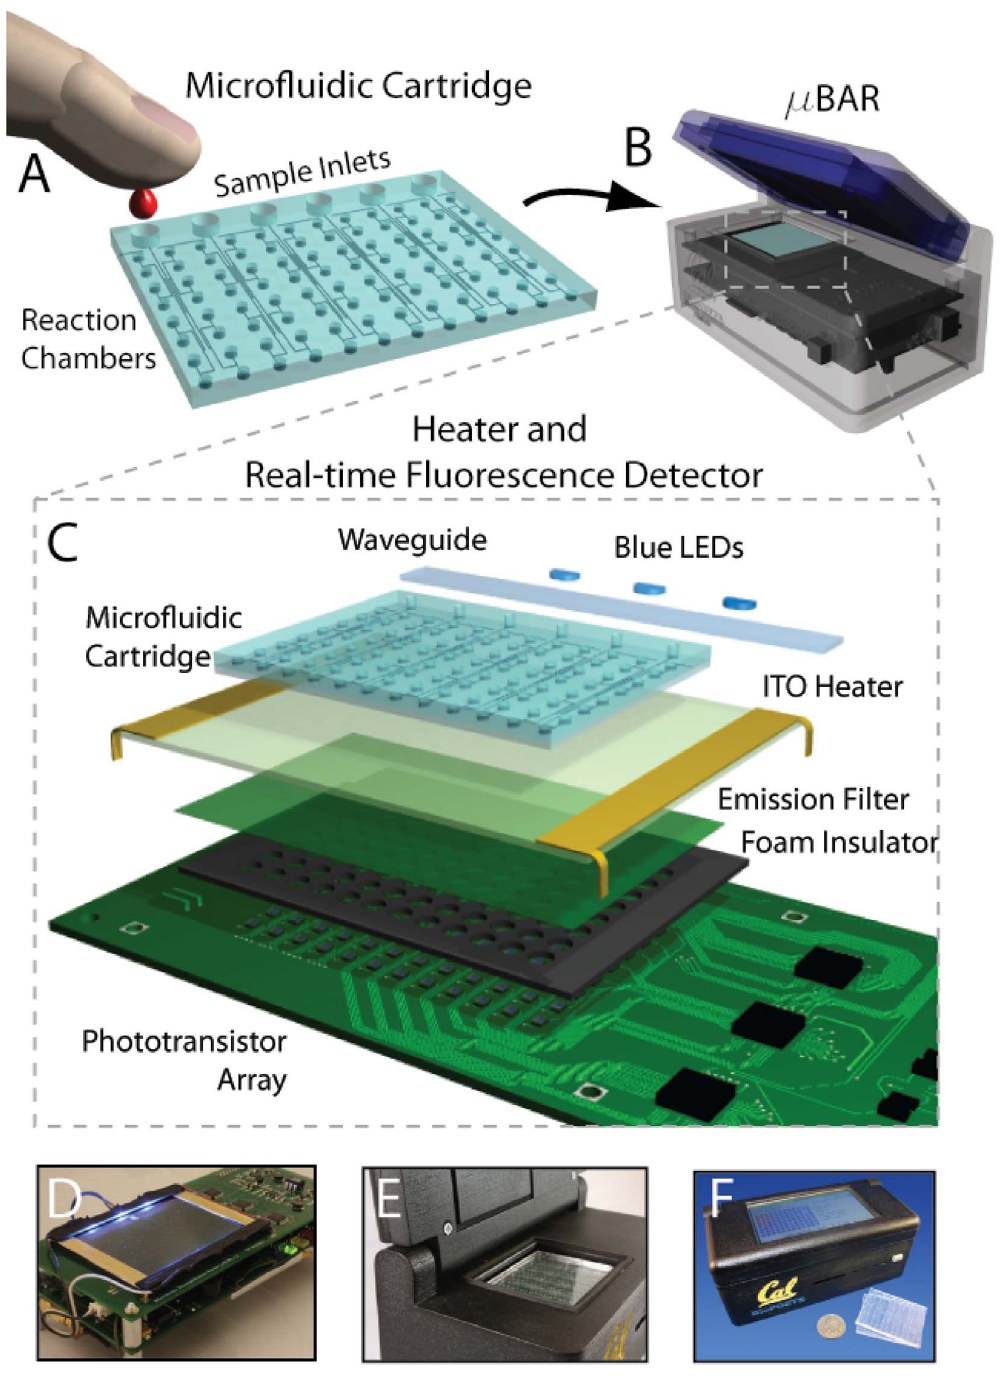
Figure 1. The design of the m BAR system and operation. (A) A disposable microfluidic cartridge is loaded with sample fluid (e.g. blood) via SIMBAS degas-driven flow. This technique proceeds automatically without any pumping or external power. LAMP reaction mix (primers, enzymes, dNTPs, etc.) may be lyophilized on-chip or mixed with the sample before loading. After 30 min, the chip is fully loaded and is placed in the m BAR instrument. (B–C) The instrument features blue excitation LEDs to the side of the chip. Waveguides help to ensure the light is efficiently coupled to the PDMS chip without stray scattering. An ITO substrate provides uniform heating across the reaction chambers of the chip. Below this substrate is a green plastic emission filter following by a neoprene foam barrier with holes which optically isolate each phototransistor on the PCB underneath. The neoprene provides both thermal and optical insulation to the system. The microfluidic chip sticks to the surface of the ITO via van der Waals forces, maximizing thermal transfer and ensuring that the chip does not move during heating. (D) m BAR with case removed, showing side LED illumination through waveguides. (E) m BAR with chip inserted. (D) Assembled handheld m BAR instrument and microfluidic cartridges with a US quarter for size